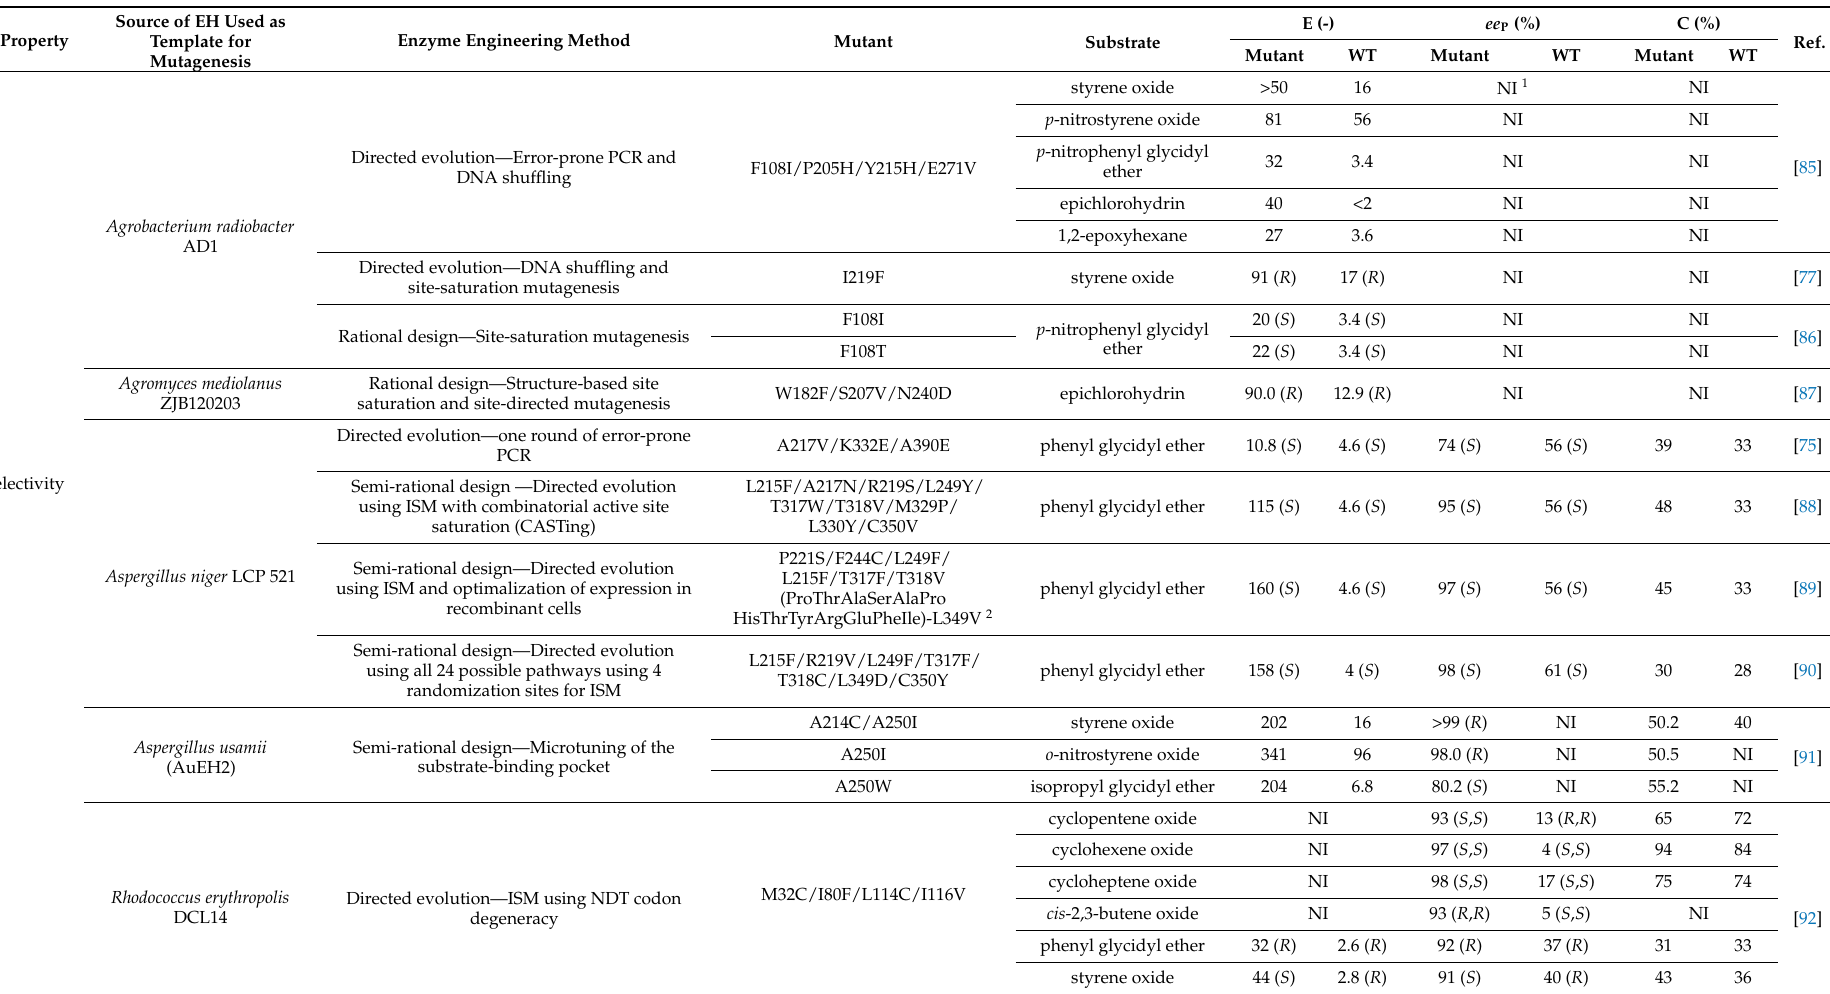
Table 2. The summary of EHs engineered for higher enantioselectivity and improved